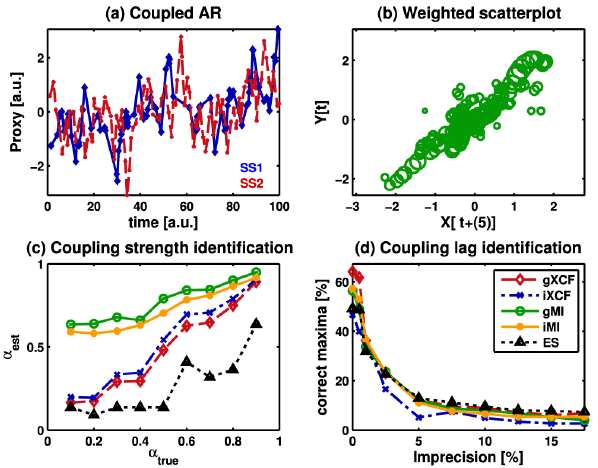
Fig. 5. Testing the similarity measures for nonlinear threshold-AR time series (cf.Eq. 17). For caption please refer to Fig.